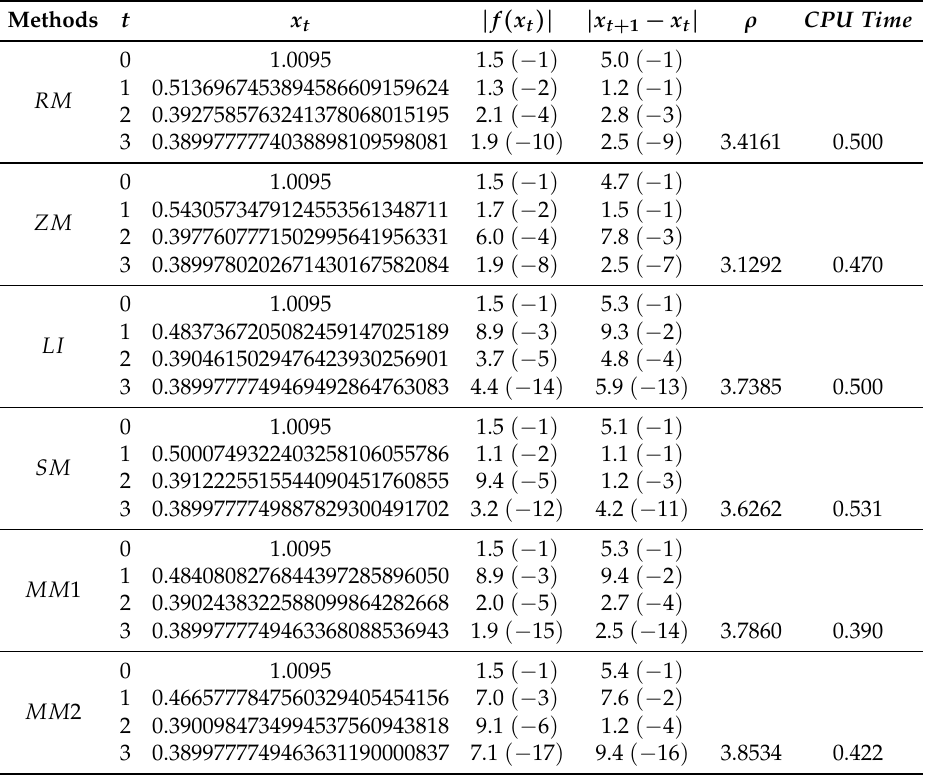
Table 7. Outcomes for comparison by testing schemes on Example